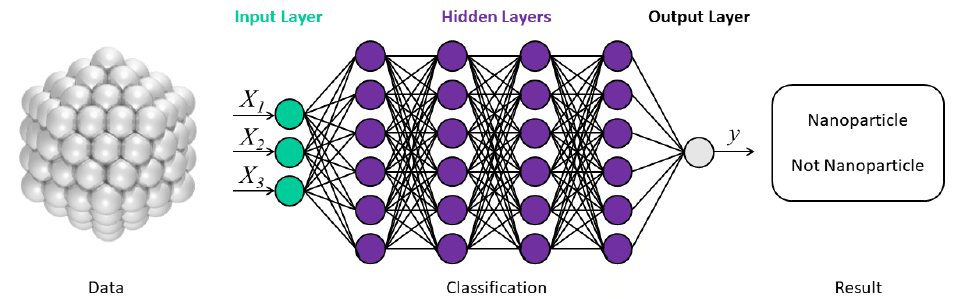
Figure 4. To predict the size distribution into a special structural identification of nanoparticle-like material by the classification model, the method of deep neural networks is used where feature extraction is automatically undertaken in additional hidden layers by artificial intelligence [96].